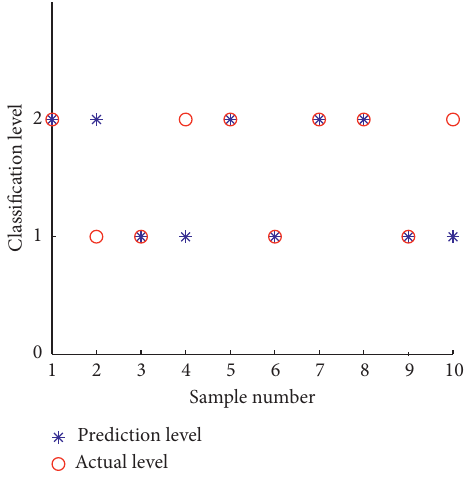
Figure 15: Test sample